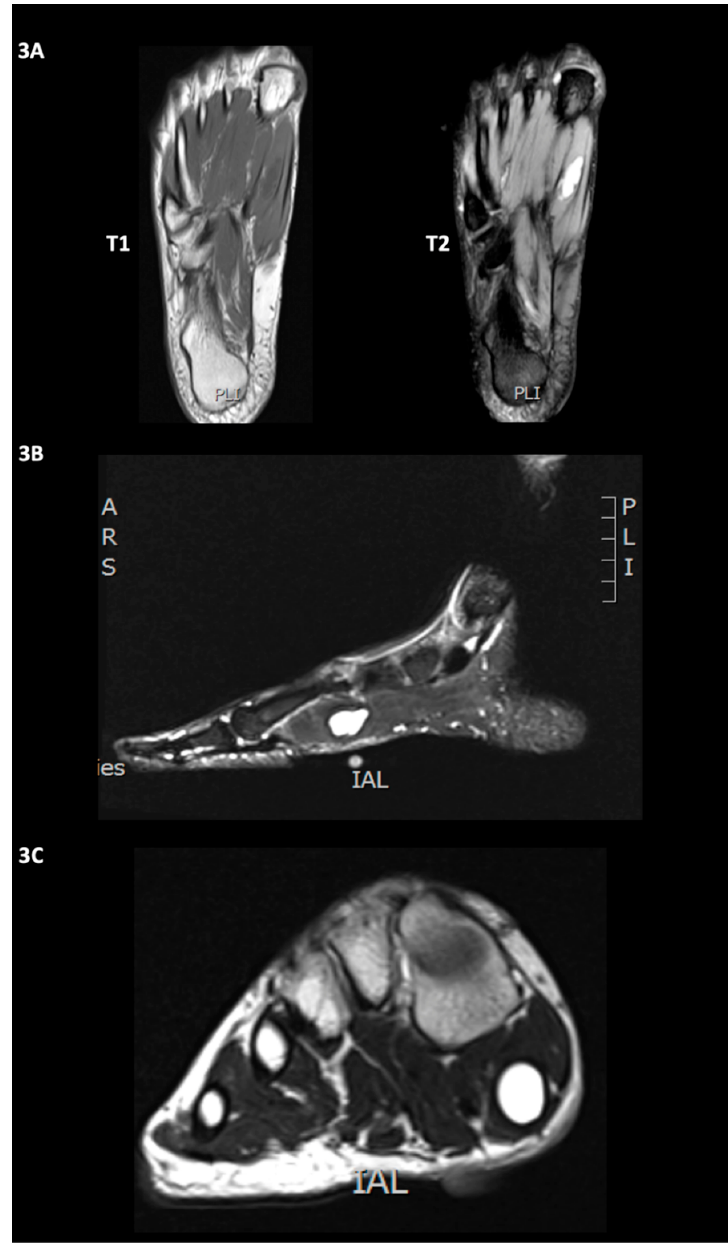
Figure 3. The MRI of the right foot in transverse axis T1 and T2 ( A ), sagittal STIR (TR: 4680, TE: 68, inversion time: 160 ms) ( B ), and coronal T2 ( C ) sequences. It revealed a smooth, well-circumscribed, unilocular and homogeneously T2 / STIR-hyperintense lesion (size, 10.0 × 20.9 × 9.1 cm) without noticeable surrounding oedema in the mid-portion of the flexor hallucis brevis muscle, consistent with an intramuscular ganglion cyst.